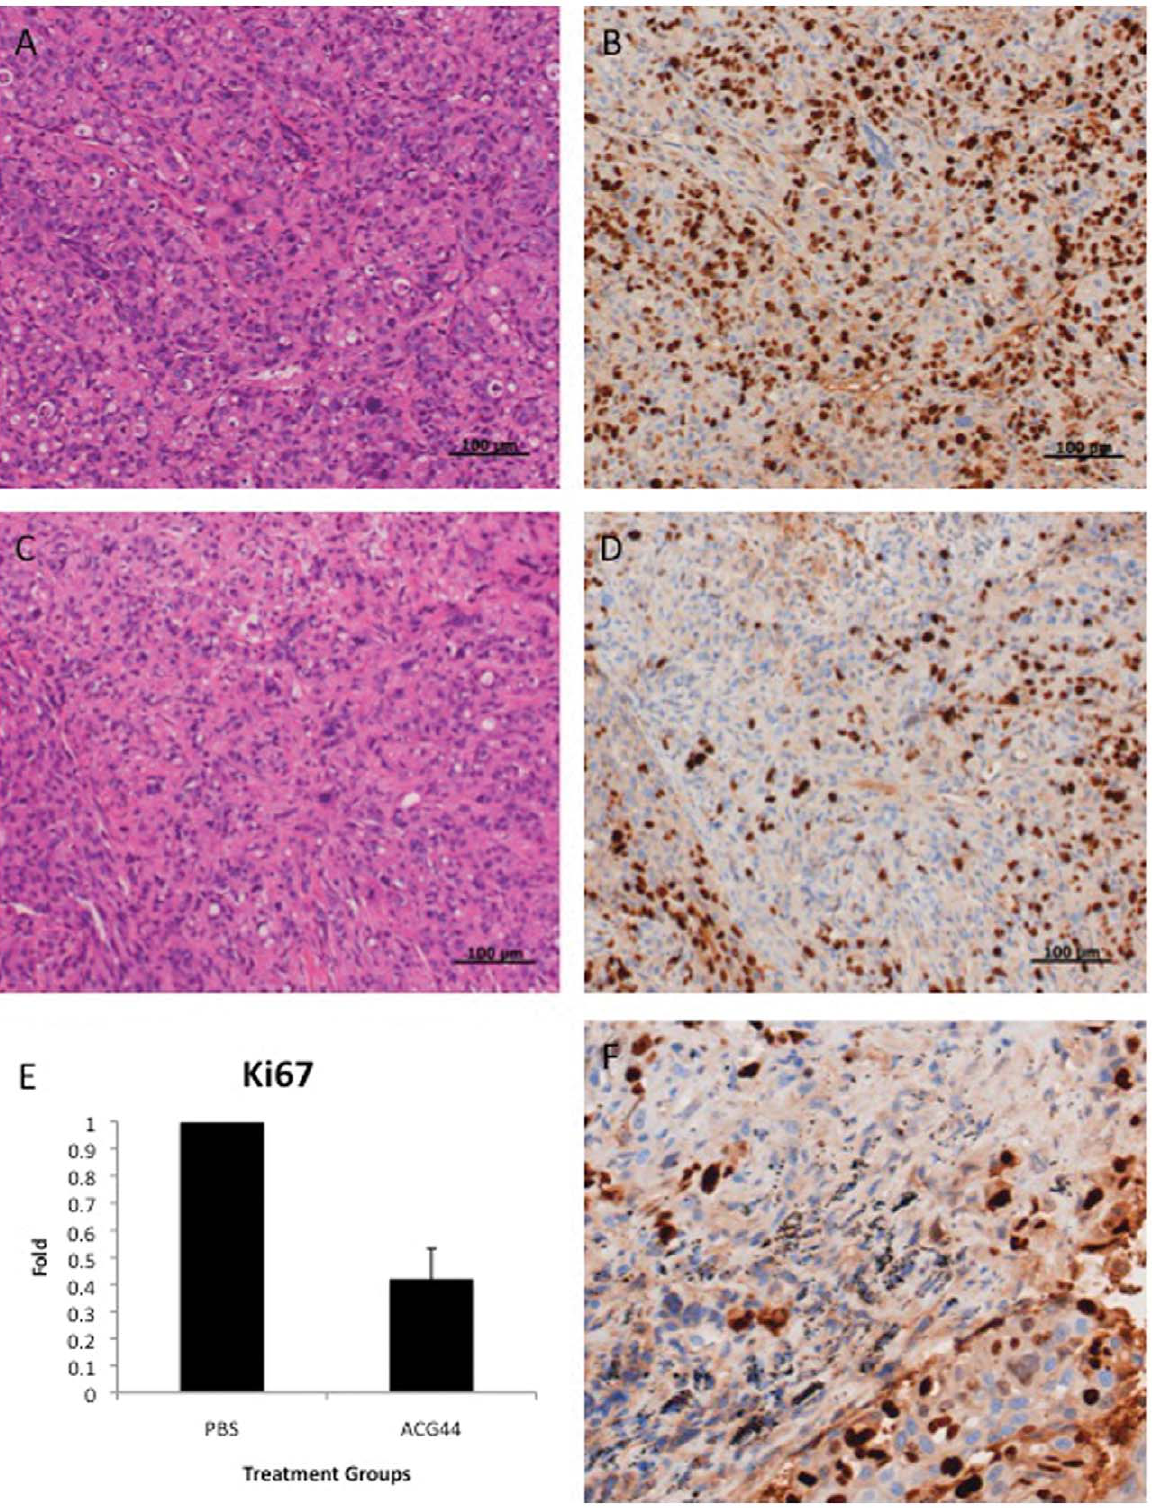
Figure 4. Immunohistochemistry Analysis of Tumors from the PBS and ACG44 groups. Figure 4A and 4B show representative images of H&E and Ki-67 stained tumor tissues, respectively, from the PBS treated group whereas Figure 4C and 4D show images of H&E and Ki-67 staining of tumor tissue from the ACG44 treated group. All images were taken with 20 6 magnification. Figure 4E is quantification of the Ki-67 positive proliferative nuclei shown in Figures 4B and 4D. Figure 4F is a tumor image of Ki-67 staining from the ACG44 treated group, taken at 100 X to show gold accumulation (black spots) at a high magnification.